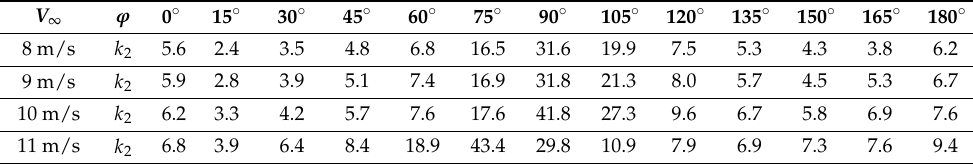
Table A2. The look-up table of different k 2 with the varying